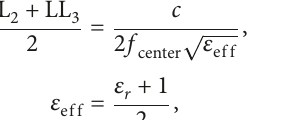
Figure 4: The comparison of the simulated isolations with and without EBG structures. (a) Isolation of the parallel-element: S of the orthogonal-element: S